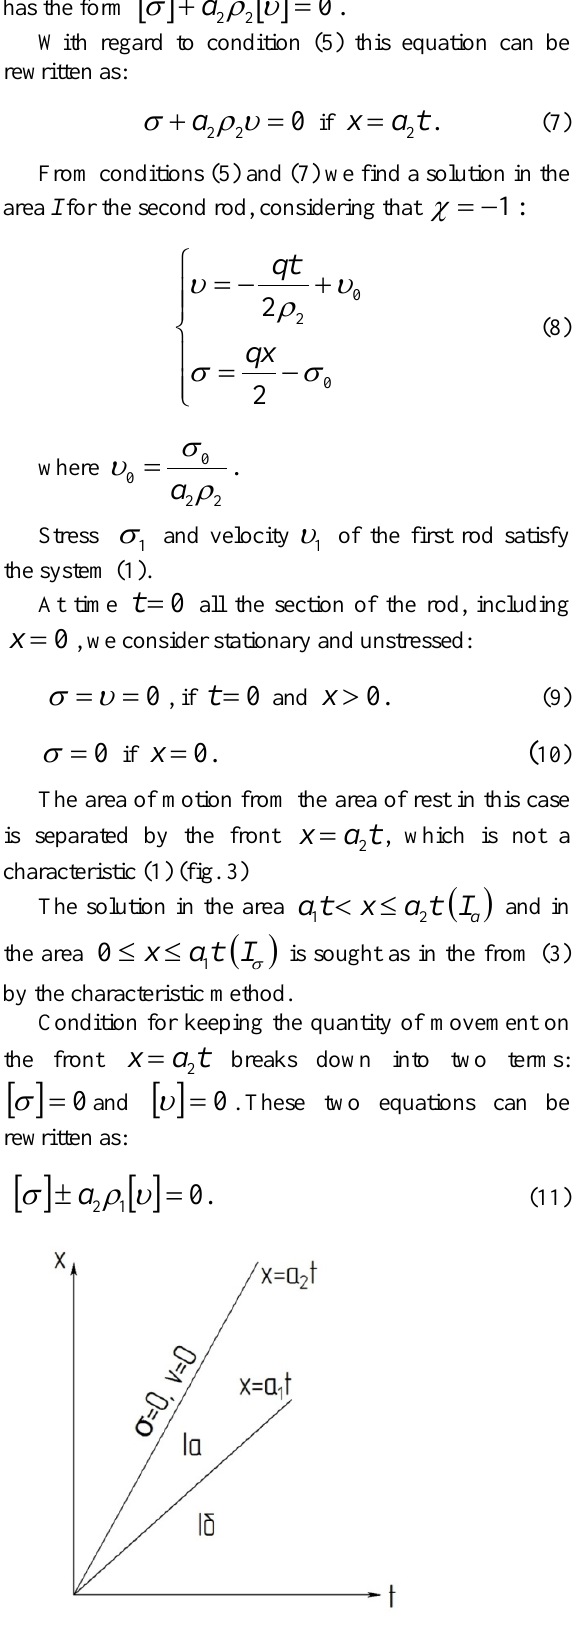
Fig. 3. The scheme of finding a solution.